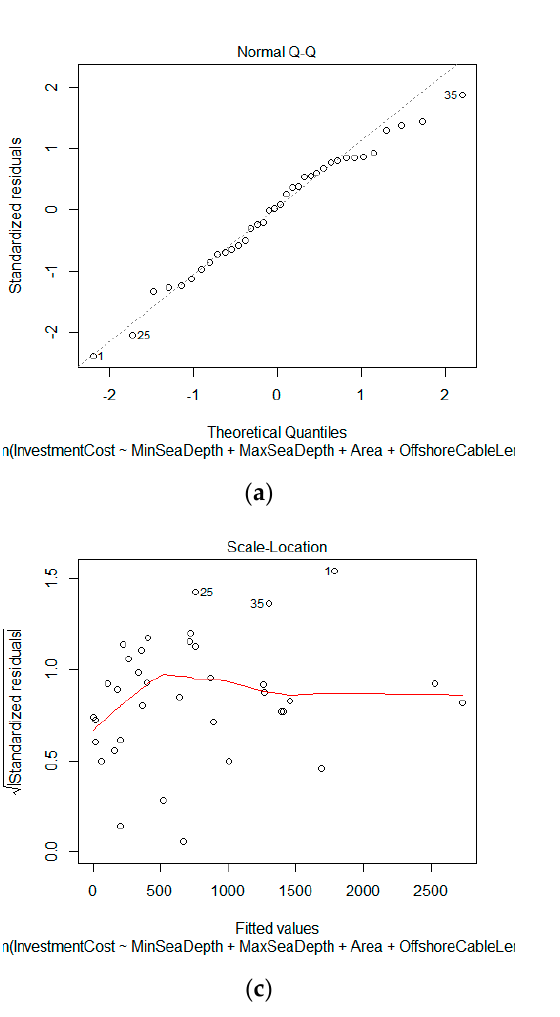
Figure 25. Multiple linear regression test for ( a ) normality, ( b ) linearity, ( c ) homoscedasticity, and ( d ) reliability of the 36 observations.